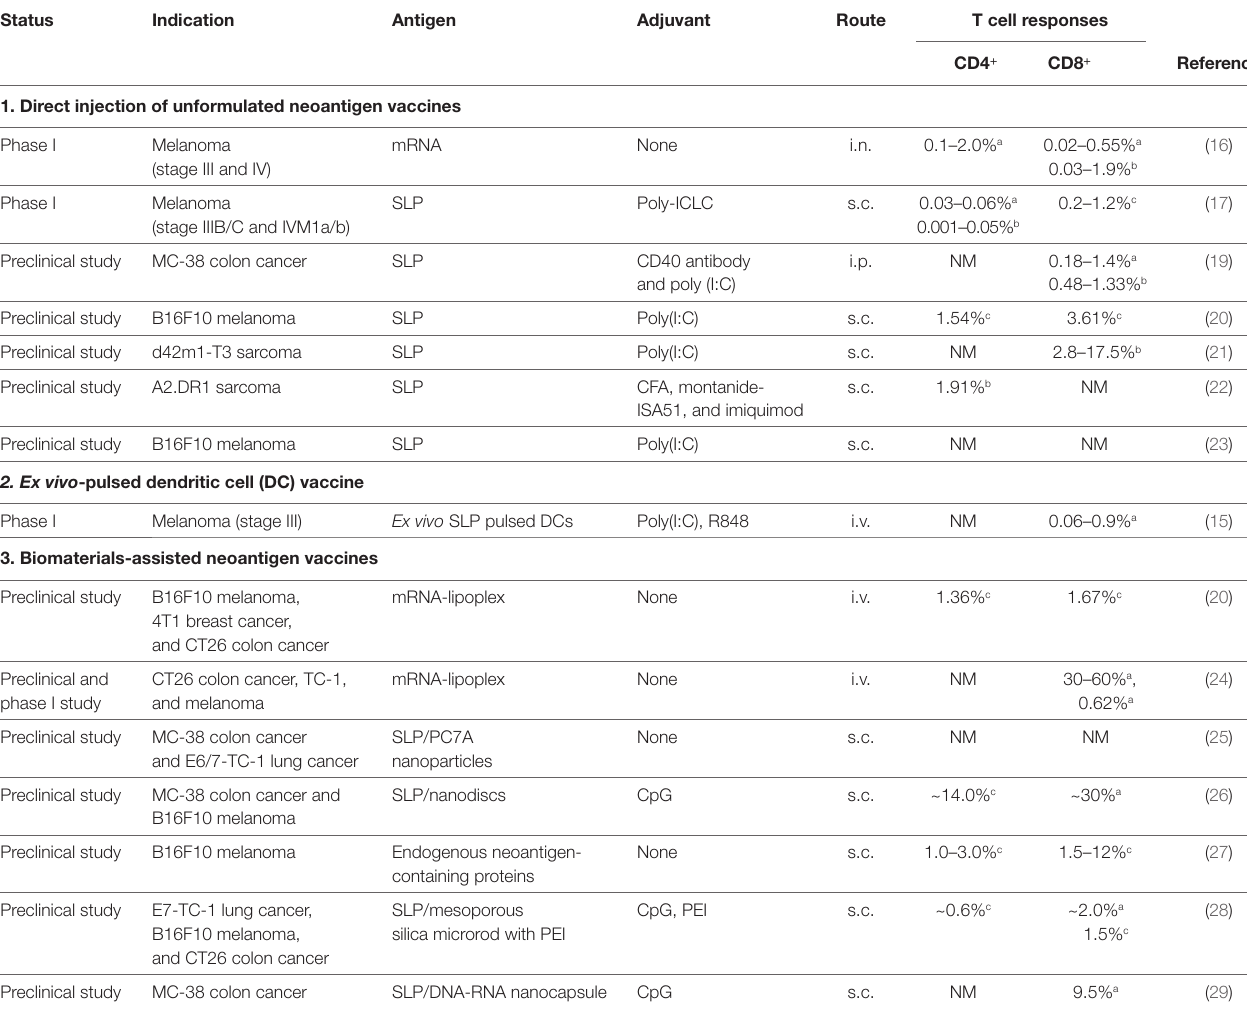
TAbLe 1 | Recent examples of neoantigen vaccine